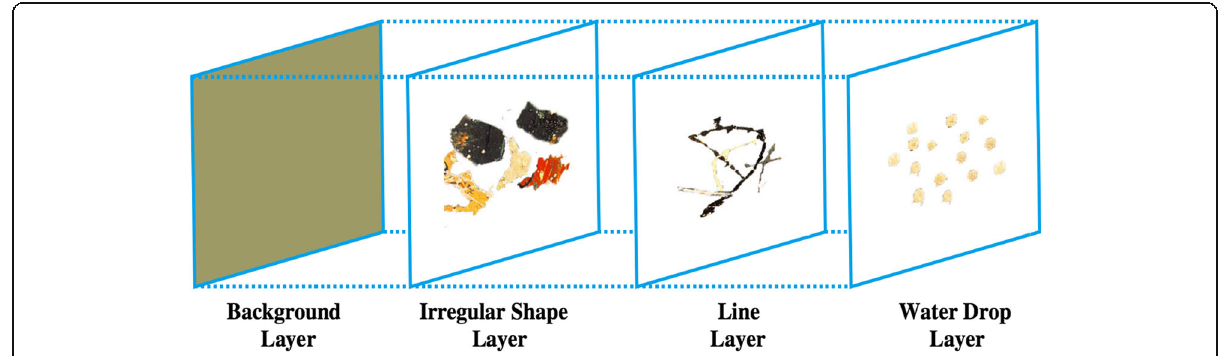
Fig. 22 Layered approach for modeling Pollock ’ s drip style